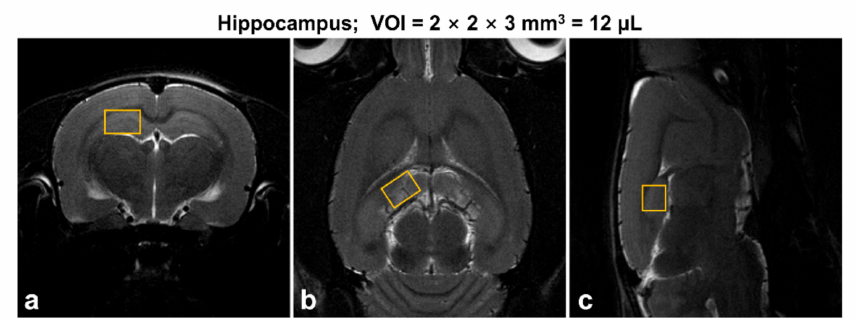
Figure 1. Representative multi-slice T2-weighted magnetic resonance (MR) images: ( a ) axial, ( b ) coronal, ( c ) sagittal, and voxel placement in the hippocampal region